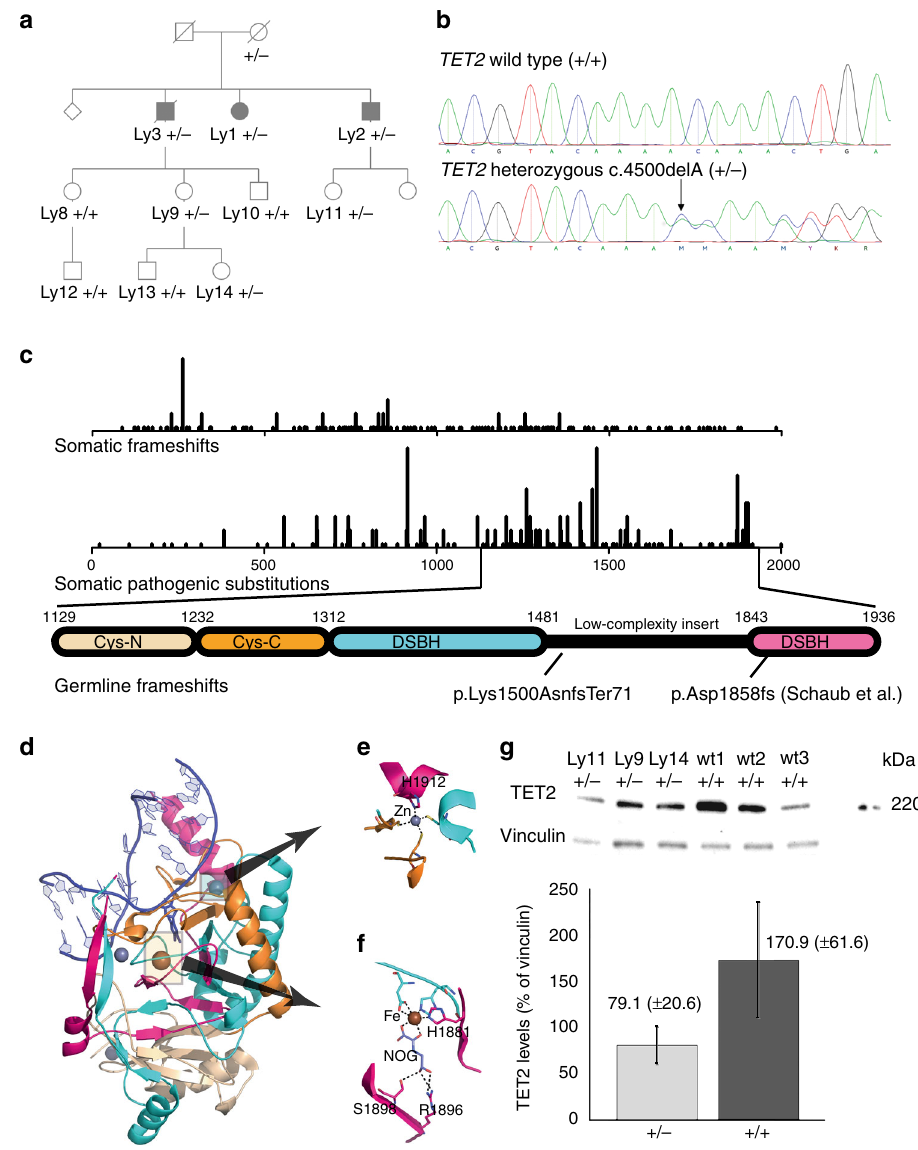
Fig. 1 TET2 c.4500delA causes loss of the protein. a Pedigree (details modi fi ed for con fi dentiality) showing TET2 c.4500delA (TET2delA) statuses; mutation carriers are marked with + / − and wild-type individuals with + / + . Solid square (male) or circle (female) depicts patients with lymphoma. b Electropherograms of TET2delA-mutated and wild-type sample. c (Upper section) Somatic frameshifts or pathogenic substitutions along TET2 in hematopoietic and lymphoid tissue malignancies from COSMIC database (release v81). (Lower section) Protein domain structure of TET2 from Hu et al. 11 . The C-terminal catalytic domain of TET2 comprises Cys-rich N-terminal (Cys-N) and C-terminal (Cys-C) subdomains, and a double-stranded β helix (DSBH) domain. Locations of germline frameshift mutations identi fi ed in this study and previously (Schaub et al. 9 ) are shown. d – f Cartoon representation of the catalytic domain of human TET2 complexed with methylated DNA (PDB entry 4nm6). Overall structure of the wild-type protein ( d ). DNA is colored with blue, fl anking Cys-rich domains are colored with light and dark orange, the DSBH core of the protein is colored with cyan and pink, the latter depicting the sequence lost due to the TET2delA mutation. The predicted loss includes residues involved in formation of the DSBH domain such as H1912 involved in coordination of Zn3-ion ( e ), as well as residues R1896 and S1898 critical for binding the substrate N -oxalyglycine (NOG) ( f ), H1881 involved in coordination of Fe-ion ( f ), and Y1902 and H1904 interacting with 5-methylcytosine. Proper folding of the mutant protein lacking these critical amino acids appears highly unlikely based on the structure. N -oxalyglycine, 5-methylcytosine, and residues mentioned above are shown with stick representation. An iron and three zinc ions are shown as brown and gray balls, respectively. g Representative western blot of TET2 from lymphoblastoid cells of three TET2delA mutation carriers and three wild-type individuals of the family. The graph shows the quanti fi cation of TET2 protein normalized to the vinculin. Bars represent the mean ± s.d. of TET2 Altogether 644/660 (97.6%) of differentially methylated regions of heterozygous TET2 p.Leu1721Trp and p.Pro363Leu ( n = 4; (DMRs) between TET2delA carriers and controls were rs34402524 and rs17253672 found in the same haplotype) to hypermethylated (Supplementary Data 1). To con fi rm that non-carriers ( n = 11), derived from two Finnish families. Blood similar changes are not found in carriers of common TET2 DNA methylation of all 15 individuals was measured by single-nucleotide polymorphisms (SNPs), we compared carriers targeted bisul fi te sequencing similar to TET2delA carriers and